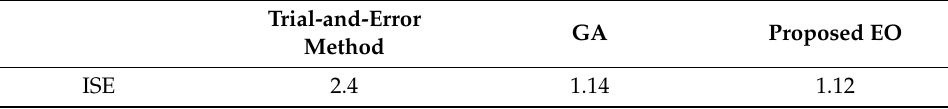
Figure 8. Residual values of the proposed dynamic cutting force model with and without the EO method: ( a ) stable cutting: 1500 rpm spindle and 1.4 mm cut depth; ( b ) stable cutting: 2250 rpm spindle and 1.4 mm cut depth; ( c ) unstable cutting: 3750 rpm spindle and 1.4 mm cut depth. Table 4. ISE values in the case of the proposed EO and different techniques in